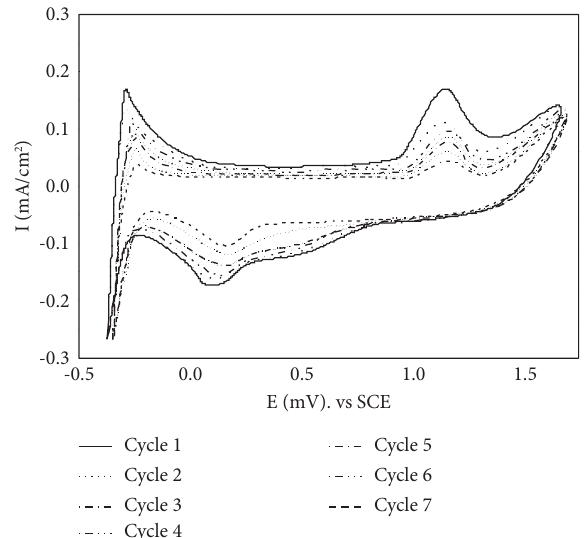
Figure 2: Efect of repetitive cycling on the cyclic voltammograms of the electropolymerization of SA from a solution containing 0.04mol · L − 1 SA and 0.30mol · L − 1 H 2 SO 4 at 313 K with a scan rate of 40mVs − 1